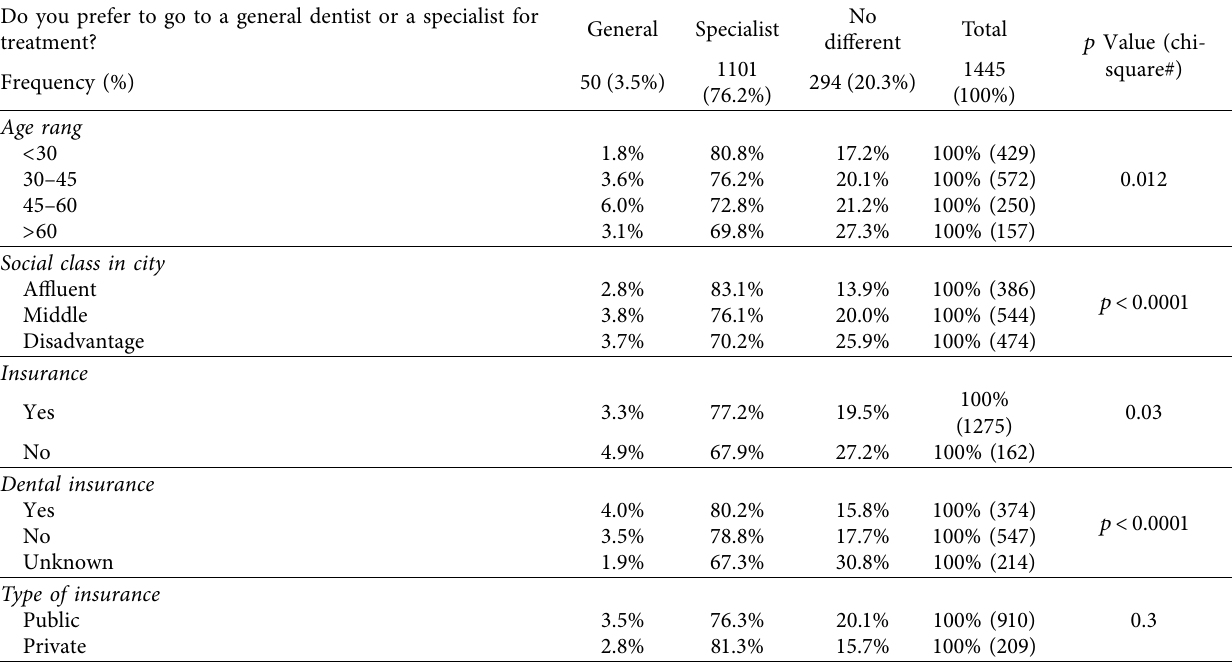
Table 3: Participant’s preferences for a specialist or general dentist according to their demographic and socioeconomic characteristics. Do you prefer to go to a general dentist or a specialist for